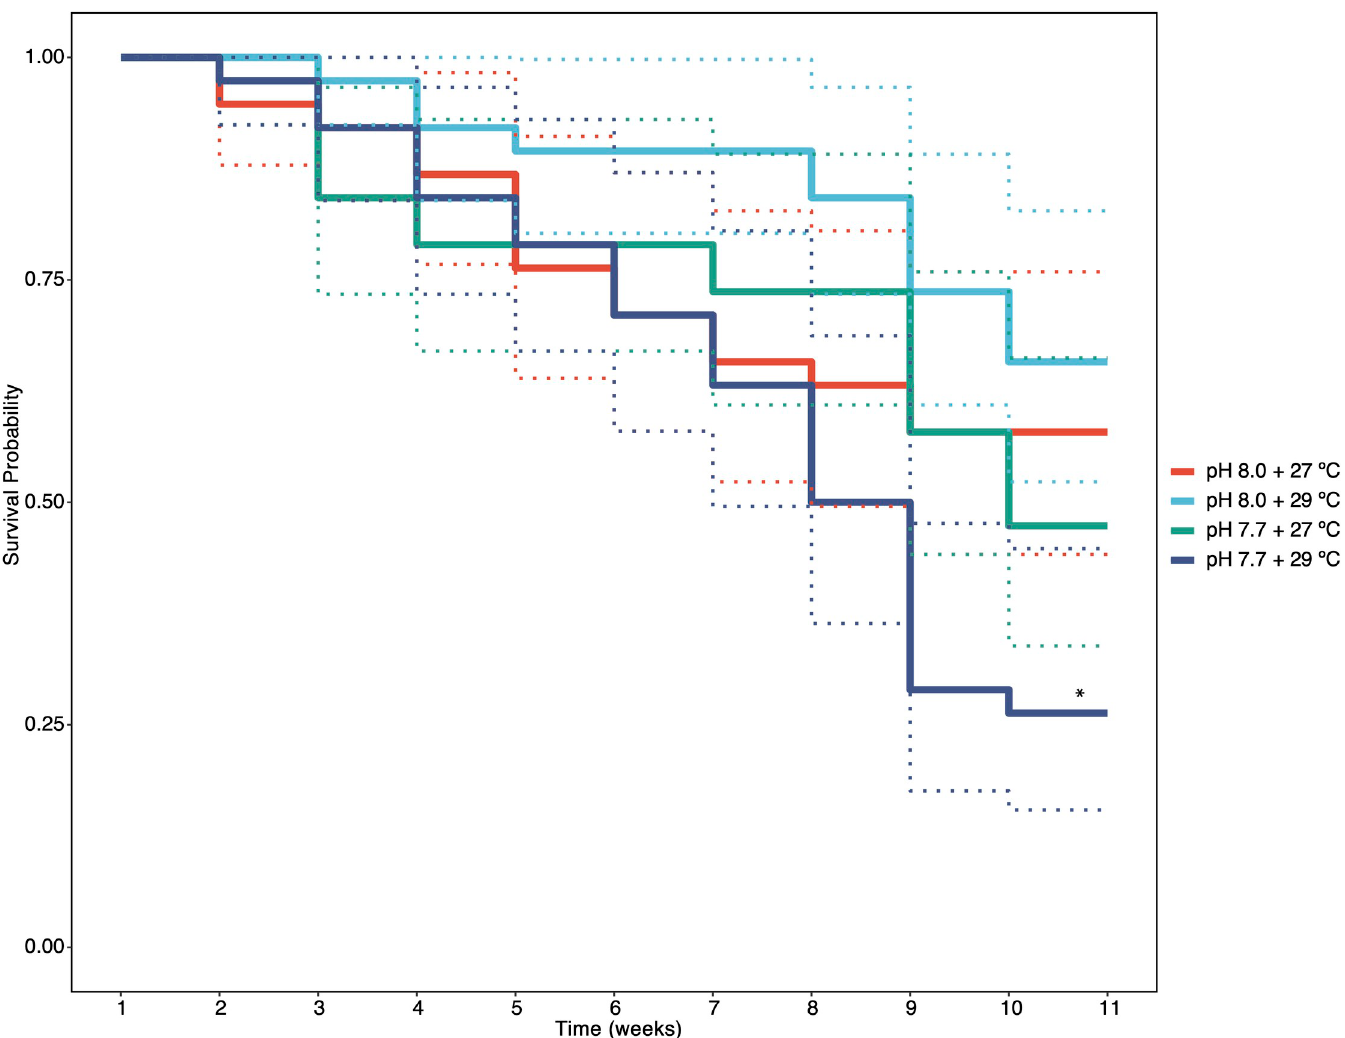
Fig 2. Survival probability of Sporolithon germlings over the duration of the experiment (11 weeks) across temperature and p CO 2 (pH) treatments. Solid lines represent mean values, and dotted lines represent 95% confidence intervals. The asterisk indicates a statistically significant difference at p <